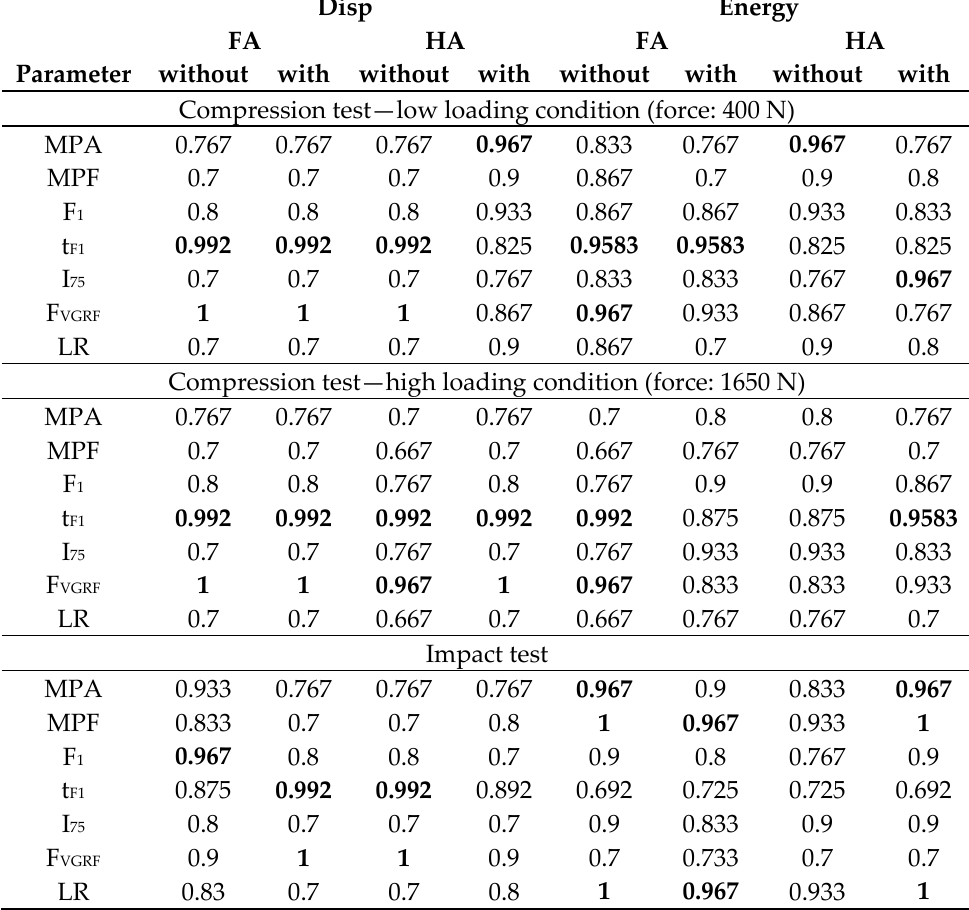
Table 3. Spearman rank-order correlation for the relation between the results of the BIO and the MATs carried out with as well as without the insoles. Bold numbers indicate a high correlation coefficient